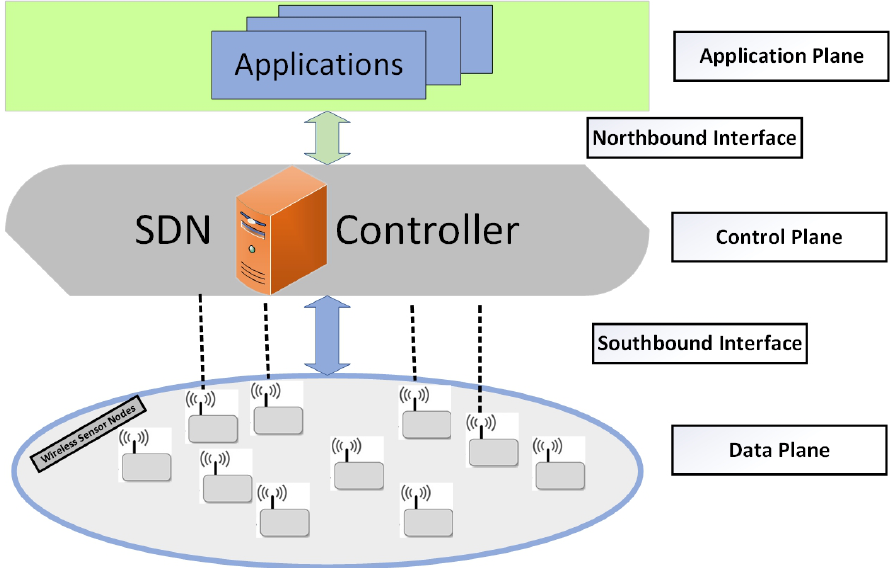
Figure 2. Software defined wireless sensor networks (SDWSNs)